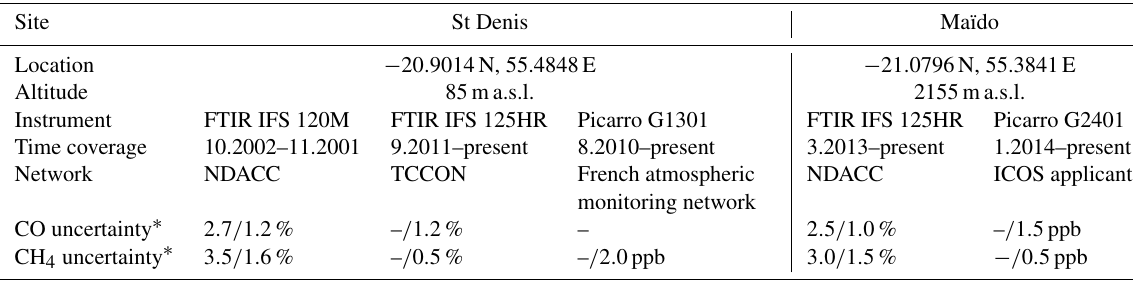
Table 1. In situ and FTIR CO and CH 4 measurements at St Denis and Maïdo.